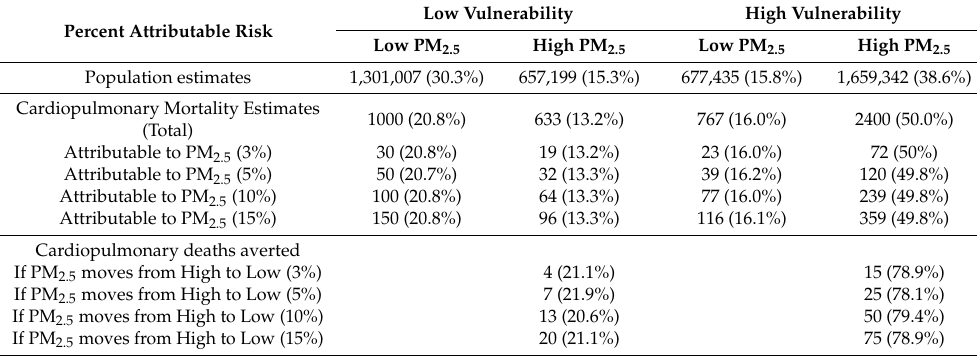
Table 4. Number of cardiopulmonary deaths averted annually by reducing PM 2.5 to low in all census tracts, by high and low vulnerability scores 1 under scenarios with 3–15% attributable risk.